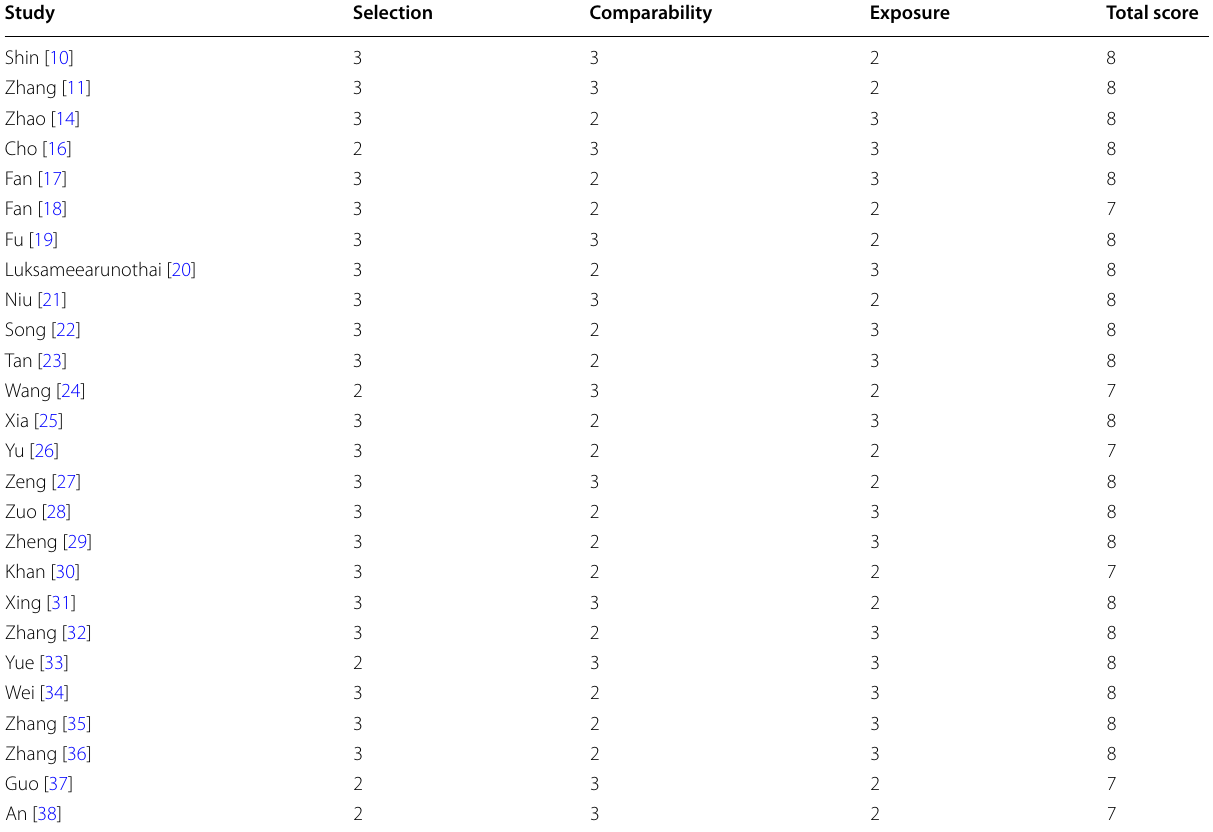
Table 2 The quality assessment according to the Newcastle Ottawa Quality Assessment Scale (NOQAS) of each study